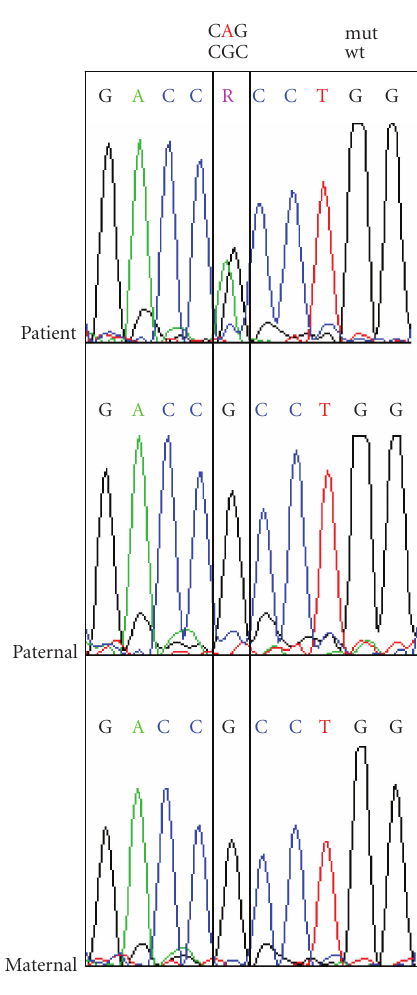
Figure 8: Sequence analysis of 374G > A; R125H in KRT14. The patient is a heterozygous carrier for this de novo mutation, whereas the parental alleles reflect wildtype status.